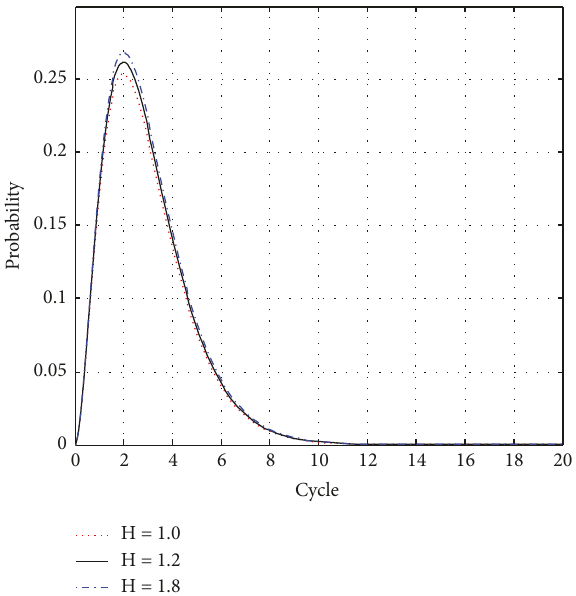
Figure 9: Sensitivity analysis of R ( t ) on H